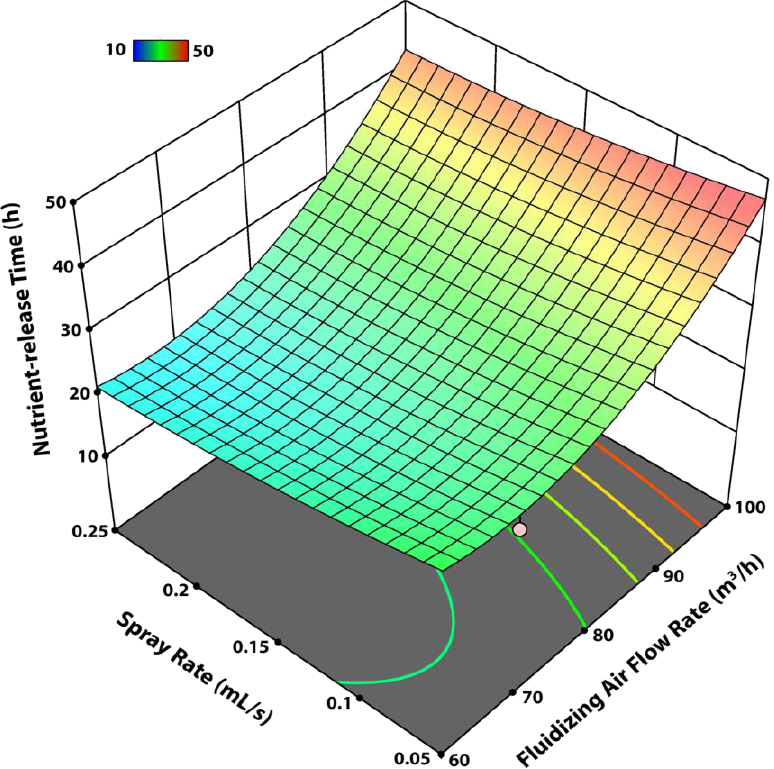
Figure 11. Interactive effect of the spray rate ( R spray ) and fluidizing air flow rate ( Q air ) on the nutrient- release time.